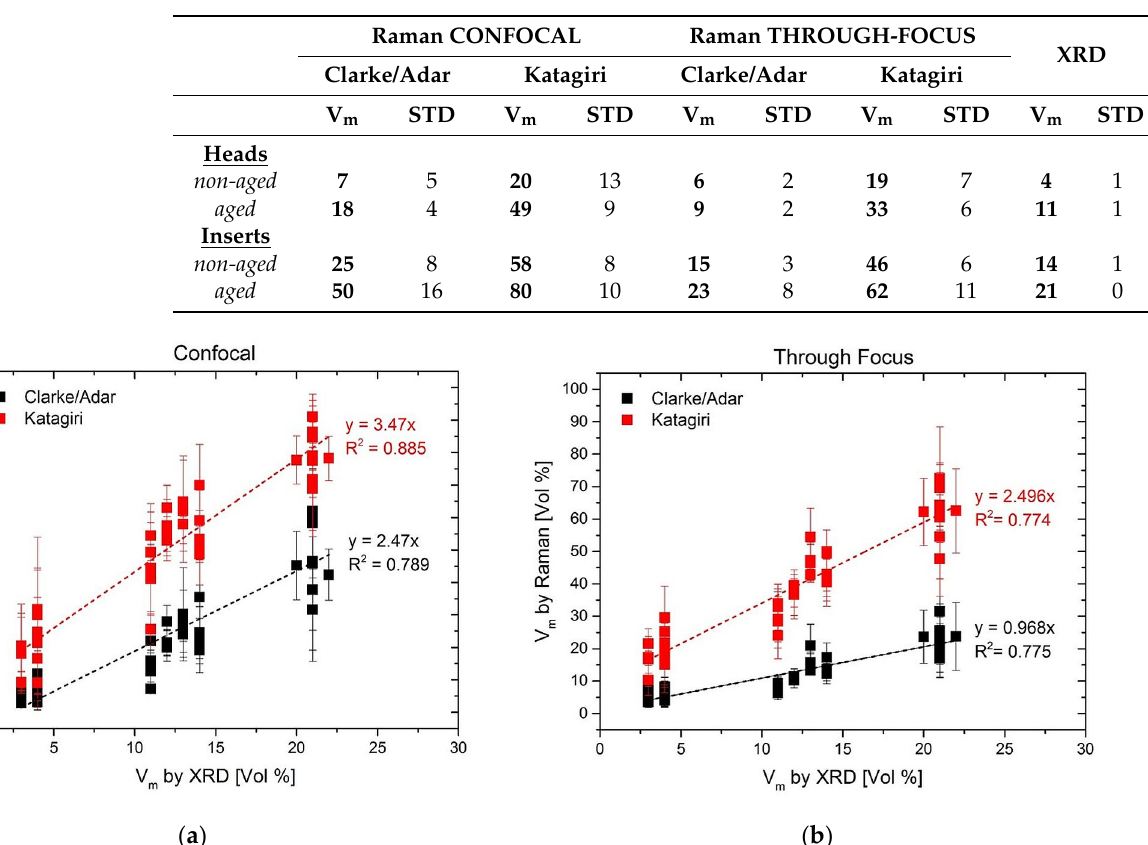
Table 1. Values of V m measured by Raman spectroscopy and XRD on both non-aged and in vitro aged Delta heads and inserts. Confocal Raman results belong to a depth up to ~4 µ m below the